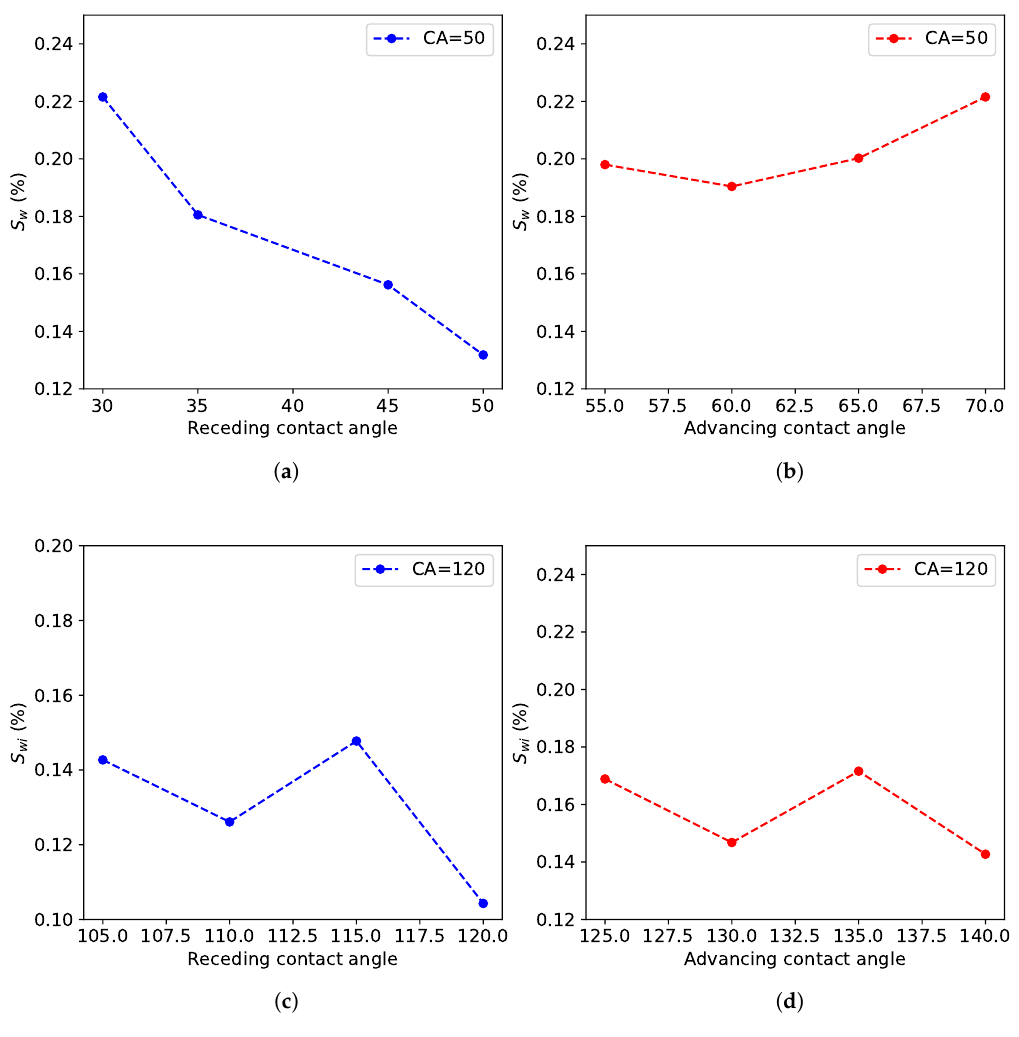
Figure 12. Sensitivity to receding and advancing contact angles in ( a,b ) water-wet and ( c,d ) oil-wet